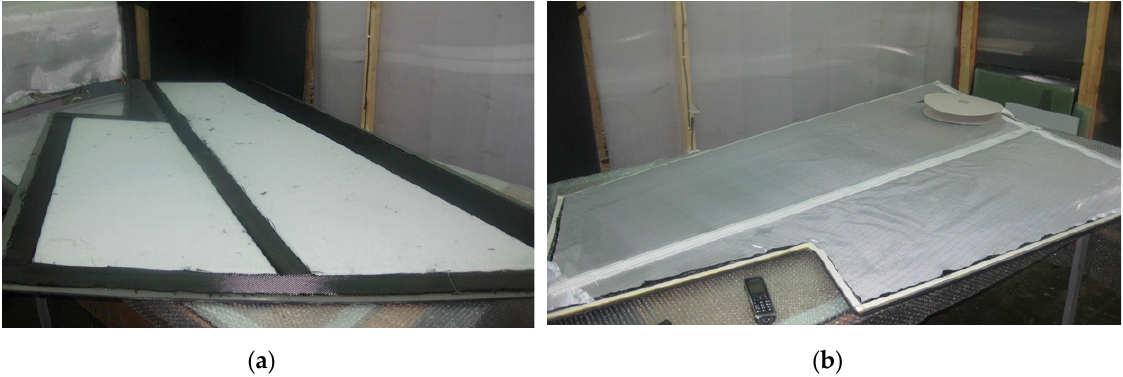
Figure 4. Assembly of the technological packet for the vacuum infusion of the sandwich tail panel: ( a ) placing of the foam plates on the first skin; ( b ) covering of the assembled preform by the resin flow distribution medium.